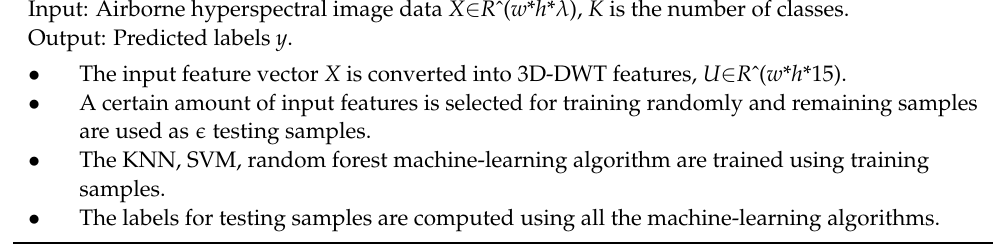
Algorithm 1 : 3D-DWT-based feature extraction for hyperspectral image classifications